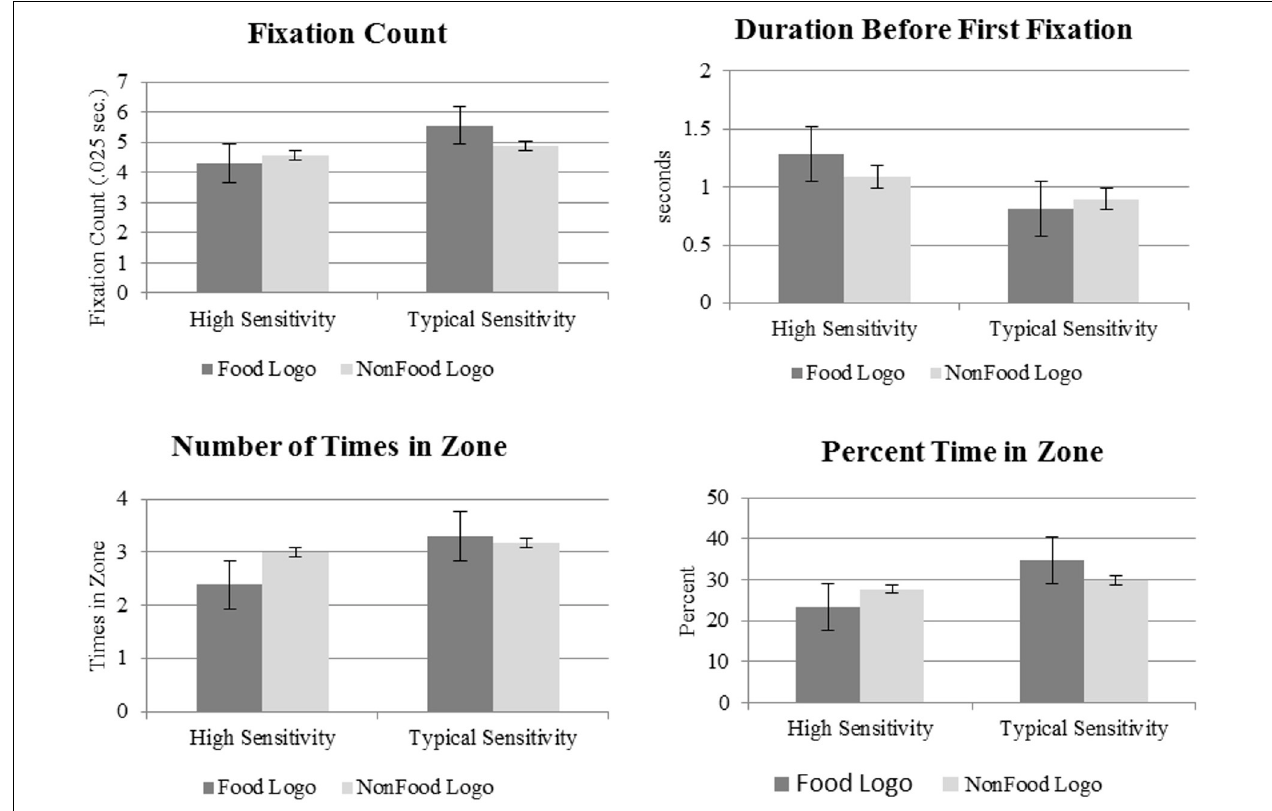
FIGURE 1 | Mean scores on eye tracking variables of interest between the high oral sensitivity and typical oral sensitivity groups.